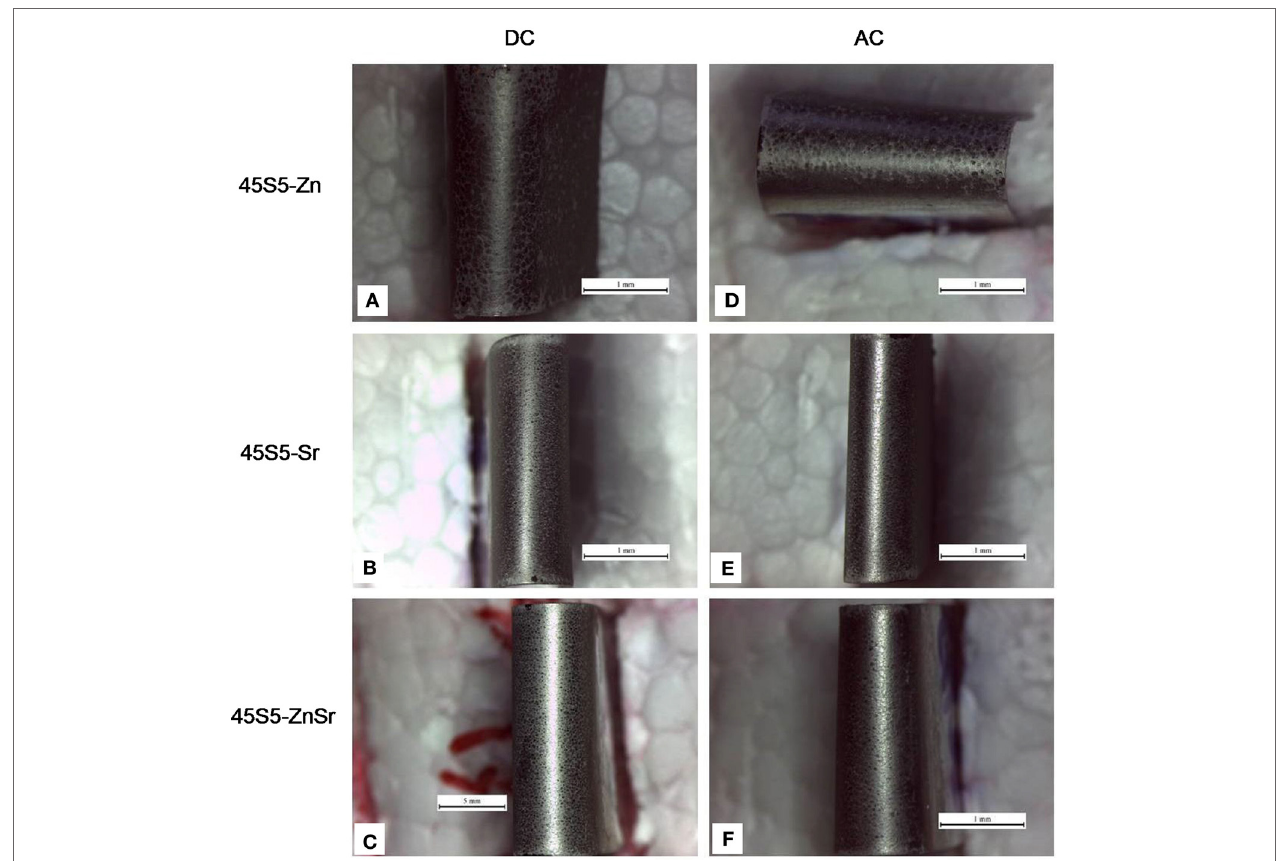
FigUre 6 | Digital camera images of the surface of coatings after bending tests . Coatings produced by means of DC-EPD (a–c) and AC-EPD (D–F) . Scale bar: 1